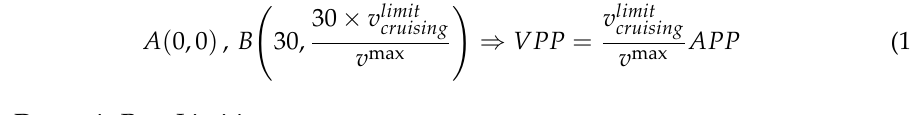
Figure 7. Real versus virtual accelerator pedal position in different operating modes.